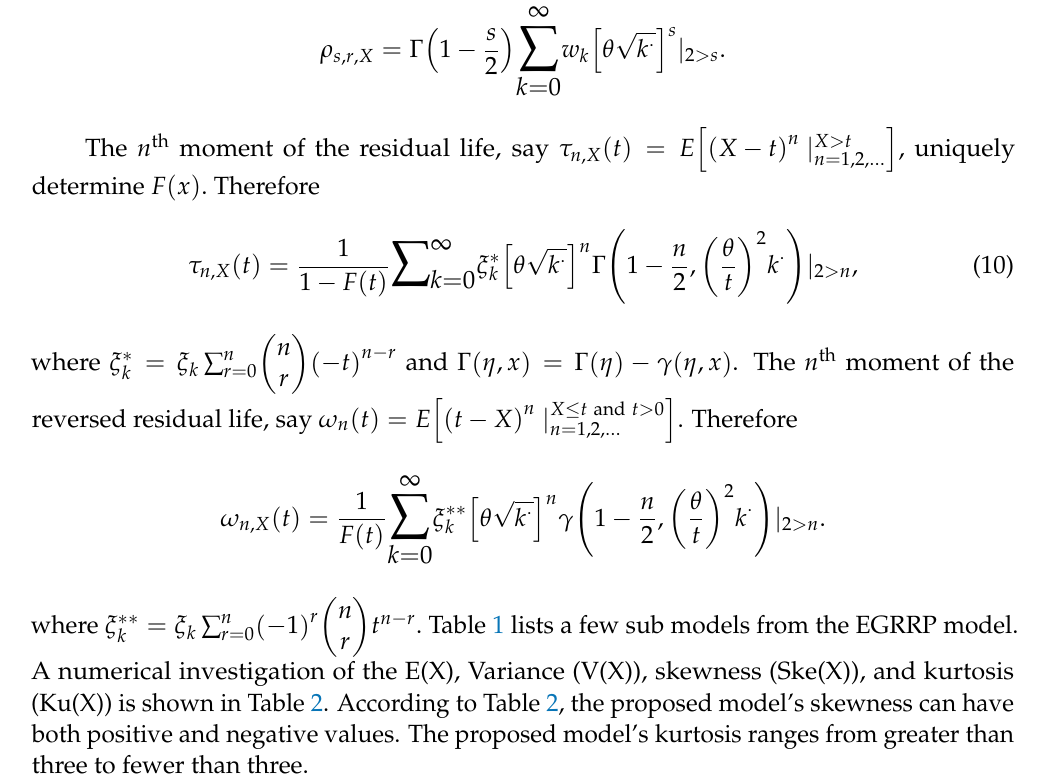
Table 1. Some sub models from the EGRRP model.